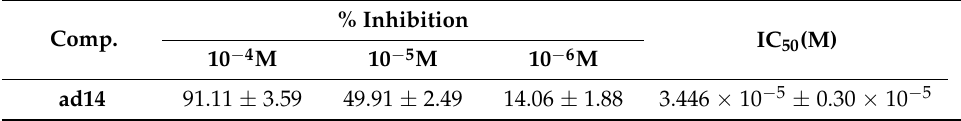
Datar et al. synthesized 3,5-disubstituted thiazolidin-2.4-dione molecules and screened